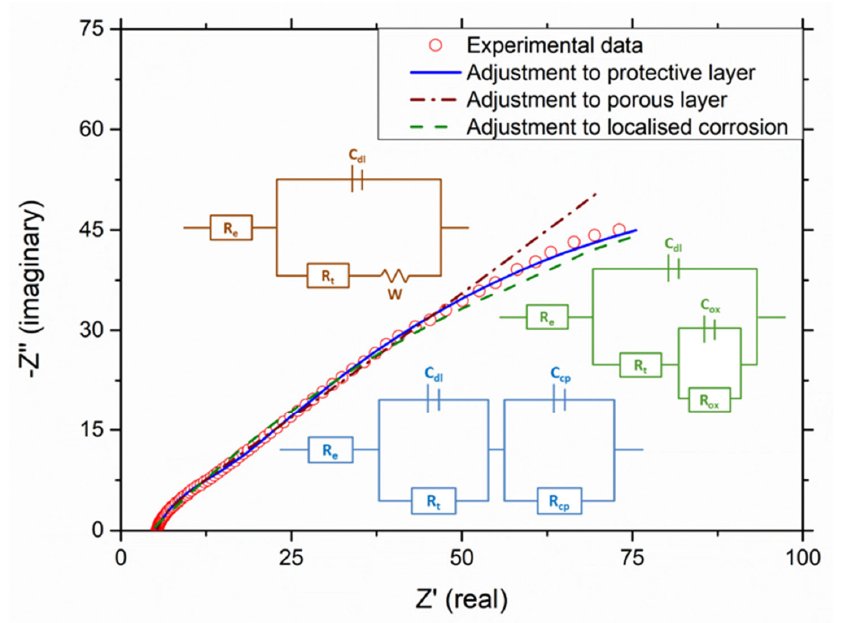
Figure 5. Adjustment of experimental data obtained after 2000 h.